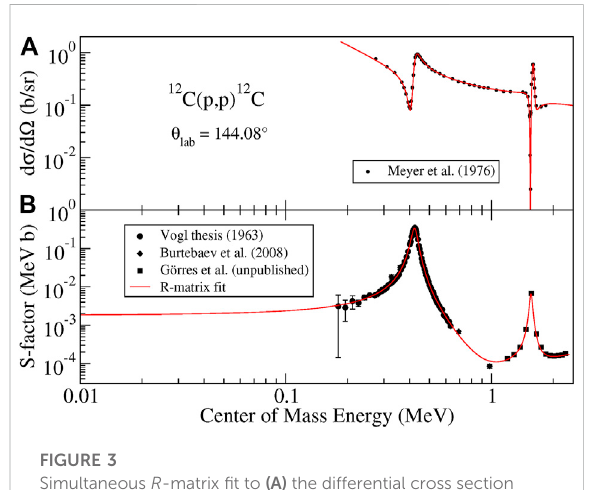
FIGURE 3 Simultaneous R -matrix fi t to (A) the differential cross section data of Meyer et al. [34], (B) the 12 C( p , γ ) 13 N angle integrated data of Vogl [35] and Burtebaev et al. [36] as well as the differential cross section data of Rolfs and Azuma [33], with adjustments for energy